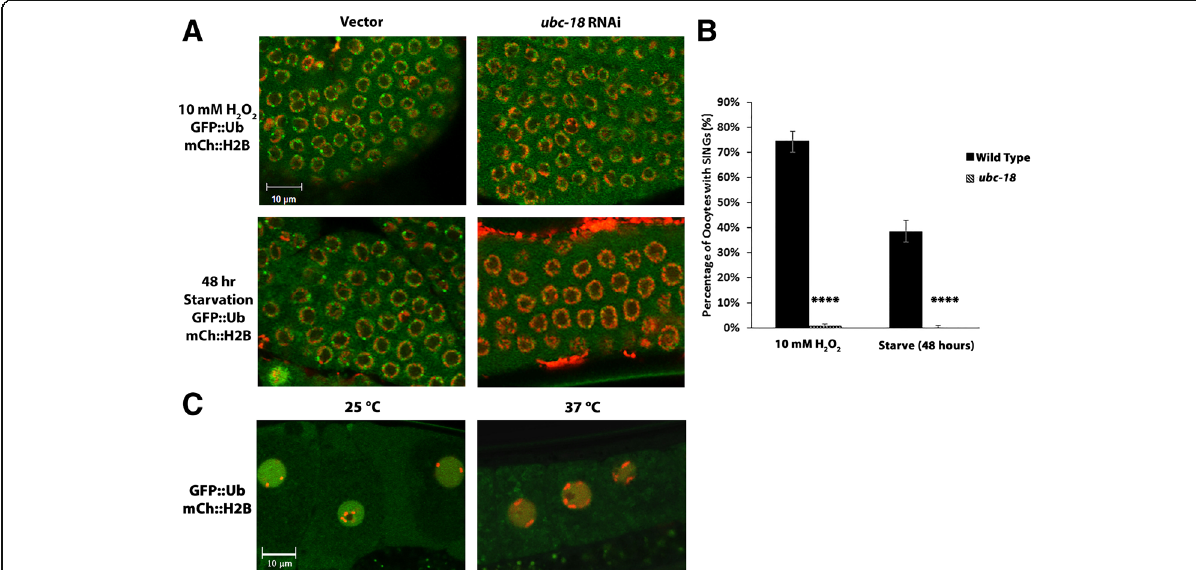
Fig. 6 Oxidative stress and Starvation induce SING formation. a Oxidative stress and starvation in gonads. Worms expressing GFP::Ub and mCh::H2B were grown on bacteria with control or ubc-18 RNAi and subjected to 10 mM H 2 O 2 for 30 min or starvation for 48 h. Distal gonads are shown. Oxidative stress and starvation induced SING formation in vector treated worms. SINGs did not form in ubc-18 worms soaked in H 2 O 2 or starved. Scale bar indicates 10 μ m. b Quantification of the percentage of oocytes forming SINGs after treatment as described in A. A total of 250 oocytes were collected from 3 independent experiments ( n =15 worms). Statistical significance was calculated by a two-tailed z test: **** p <0.0001. c Heat shock does not induce SINGs. Worms expressing GFP::Ub and mCh::H2B were subjected to heat shock by placing them at 37 °C for one hour. In control worms incubated at 25 °C for 1 h, 0/600 oocytes showed SINGs. In the heat shock group, 0/600 oocytes showed SINGs. Data were collected from 2 independent experiments ( n =20 worms). Scale bar indicates 10 μ